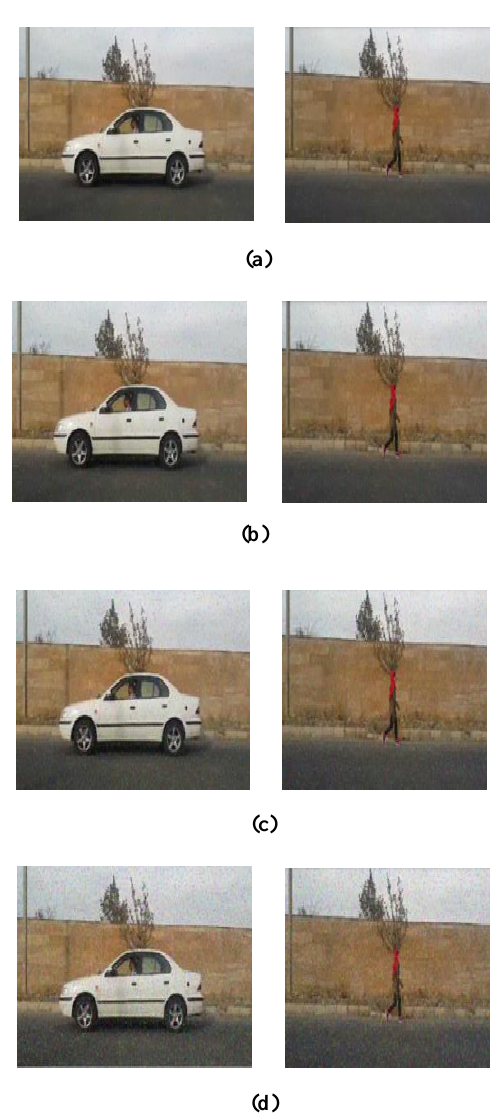
Figure 4. Resolution reduction effect of various input noise. (a) input noise